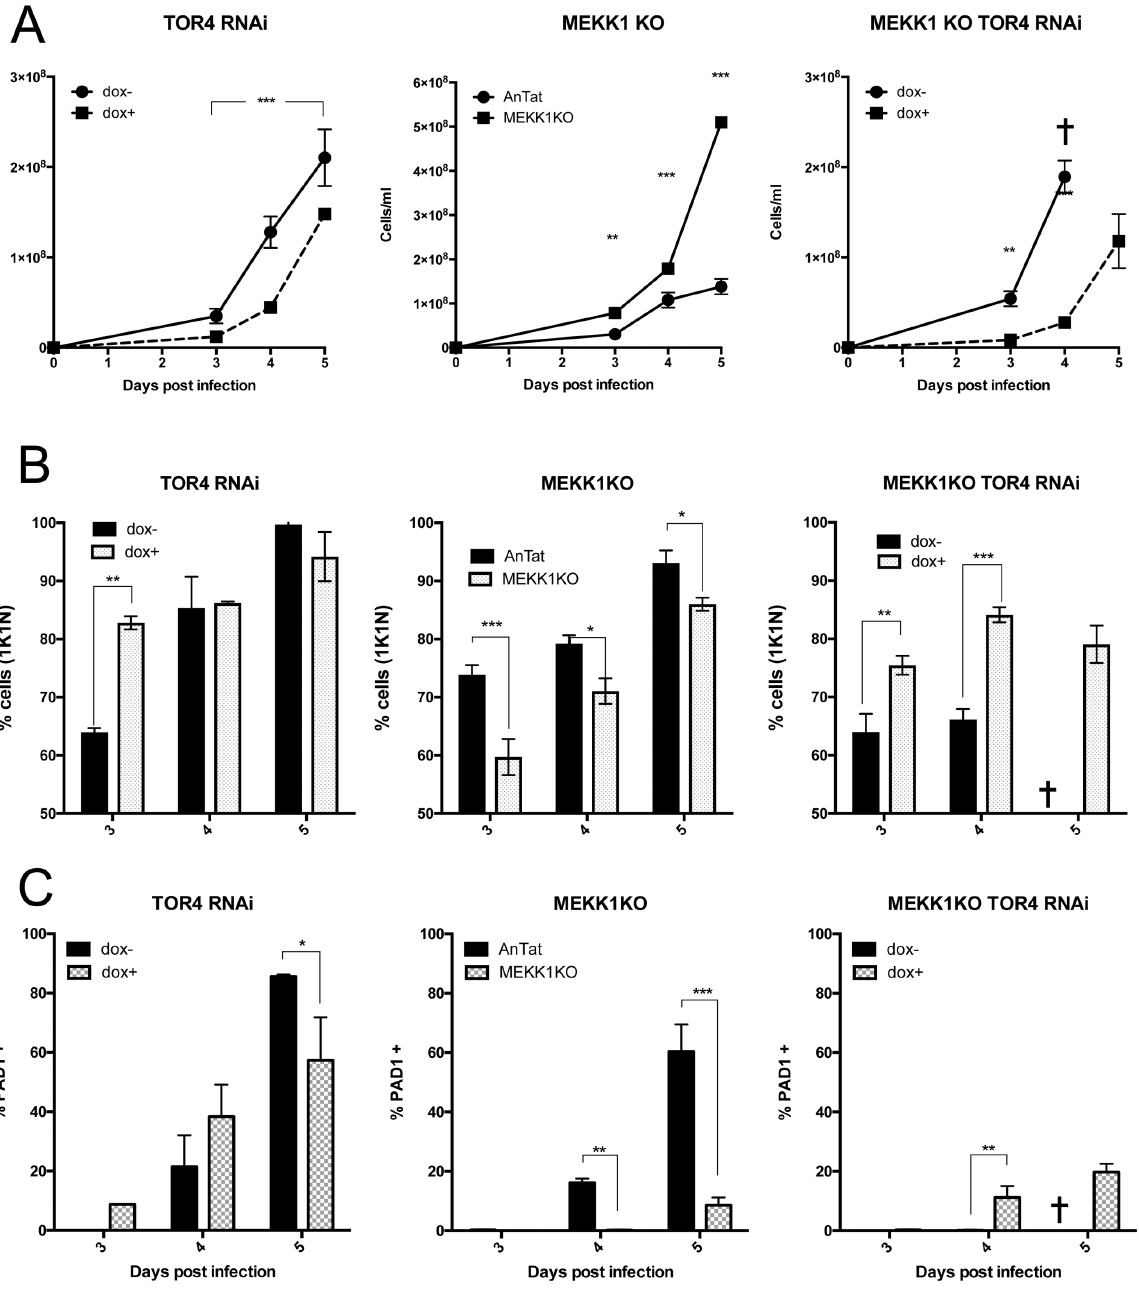
Fig 8. TbTOR4 drives growth arrest independently of MEKK1. A. Parasitaemia of the TbTOR4 RNAi line, MEKK1 null mutant, or TbTOR4 RNAi in the MEKK1 null mutant. In the left hand panel, TbTOR4 silencing promotes stumpy formation; Doxycycline + (RNAi induced; ■ ), doxycycline– (RNAi uninduced; ● ). In the middle panel, the MEKK1 null mutants ( ■ ) are more virulent than parental (‘AnTat’) cells ( ● ), consistent with the reduced capacity for stumpy formation. In the right-hand panel, when TbTOR4 is depleted by inducible RNAi ( ■ ) MEKK1 null mutants show slow growth compared with MEKK1 null mutants where TbTOR4 is not depleted ( ● ). Infections were humanely terminated in the uninduced MEKK1 KO TbTOR4RNAi infections on day 4 and so day 5 data is absent ( ✝ ). (cid:3) , p < 0.05; (cid:3)(cid:3) , p < 0.005; (cid:3)(cid:3)(cid:3) , p < 0.0005. B. Cell cycle progression of the cell lines analysed in vivo in Panel A. Left panel, TbTOR4 RNAi shows enhanced levels of 1K1N cells at day 3 of infection, but by day 4 the uninduced cells have also progressed to stumpy forms. Middle panel, MEKK1 null mutants show less accumulation in 1K1N than parental (‘AnTat’) cells. Right hand panel; when TbTOR4 is depleted in the MEKK1 null mutant, parasites show a higher proportion of 1K1N cells, such that TbTOR4 depletion overrides the absence of MEKK1 .Infections were humanely terminated in the uninduced MEKK1 KO TbTOR4 RNAi infections on day 4 and so day 5 data is absent ( ✝ ). (cid:3) , p < 0.05; (cid:3)(cid:3) , p < 0.005; (cid:3)(cid:3)(cid:3) , p < 0.0005. C. PAD1 expression when TbTOR4 RNAi is induced in parental cells (left hand panel) or in the MEKK1 null mutant (right hand panel). In the TbTOR4 RNAi line on day 5 PAD1